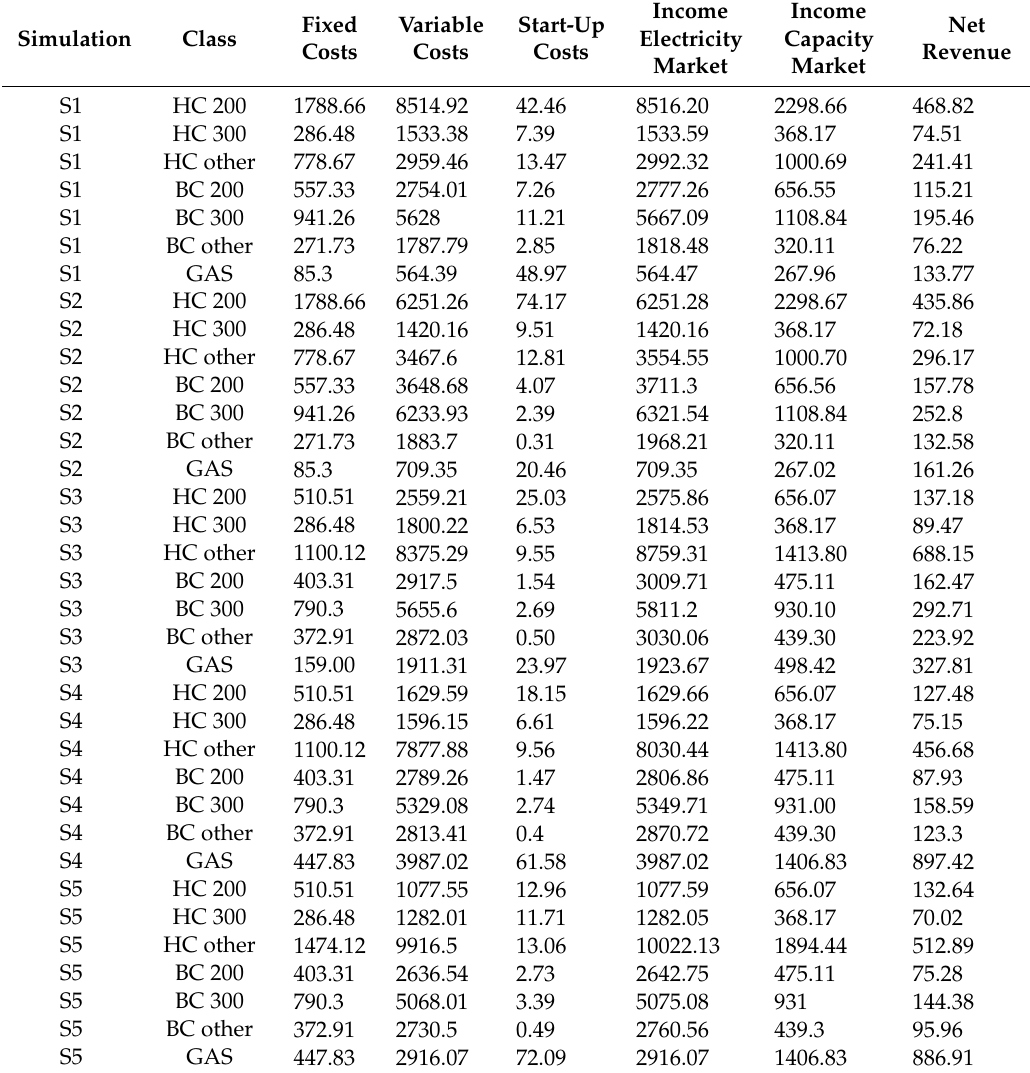
Table 9. Economic results